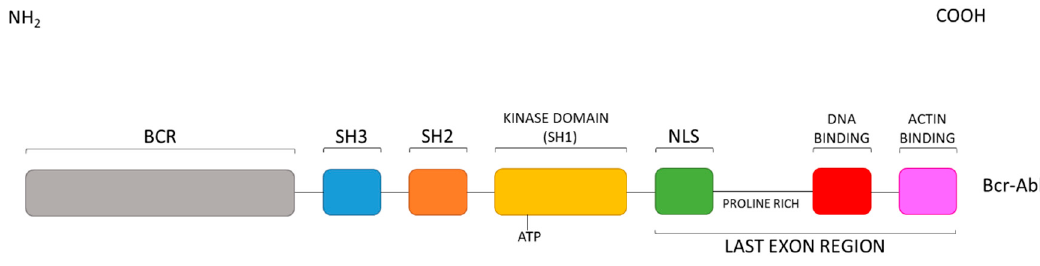
Figure 3. Bcr-Abl domain order.